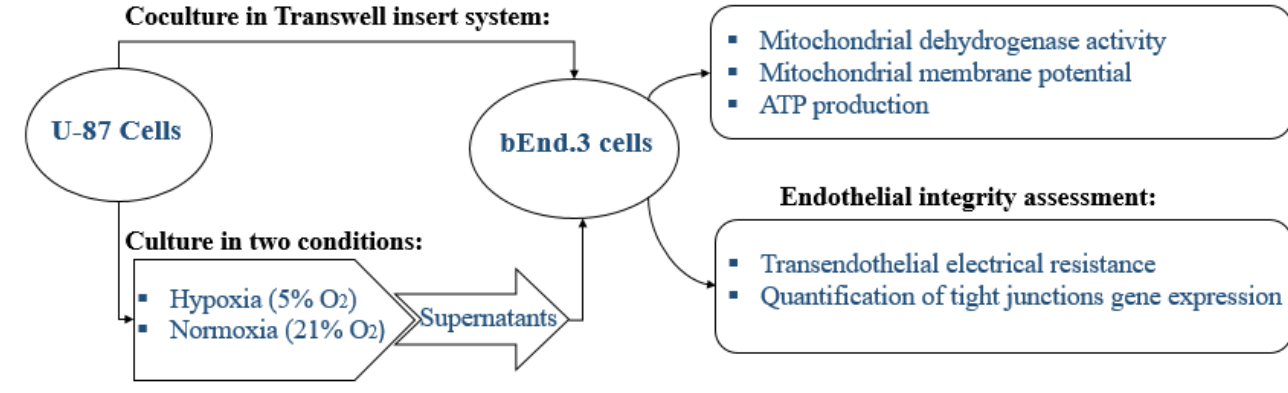
Figure 1. A schematic diagram of the research design to study the effect of the paracrine factors secreted by U-87 cells on bEnd.3 cells.